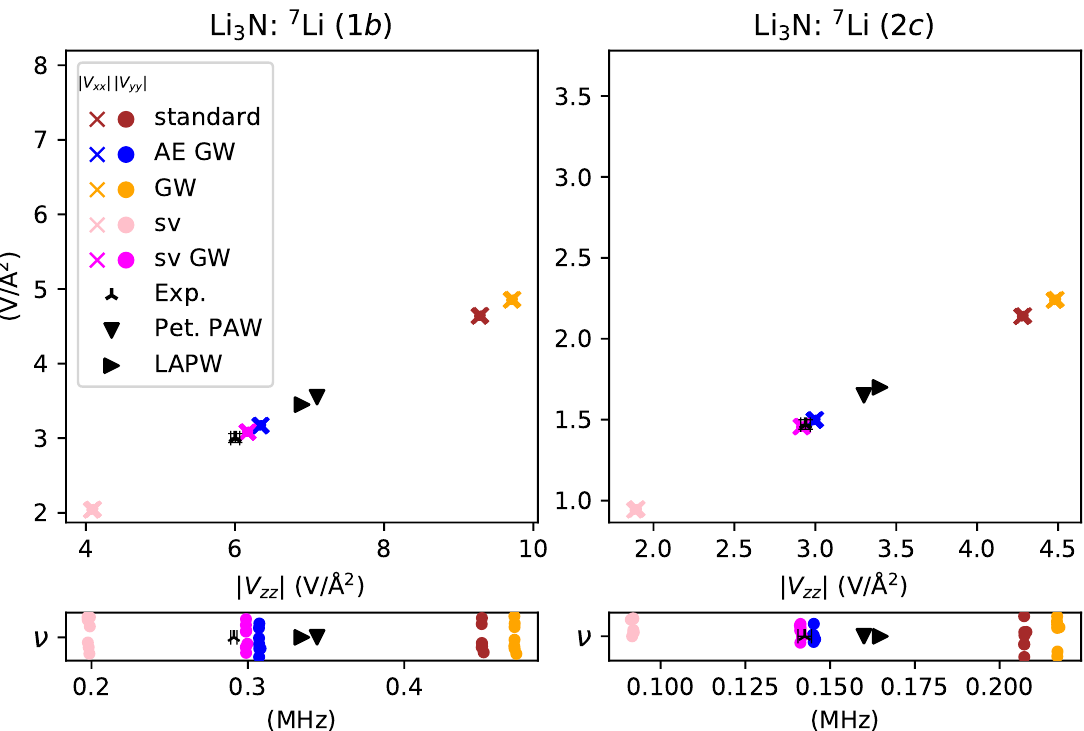
Figure 5. EFG plots for both 7 Li sites, denoted by their Wychoff positions, in Li 3 N are shown at the top; the corresponding NQR frequencies are shown underneath. Colored markers show a computed value for each PAW potential and experimental data [40] is shown as a three-pointed star. The potential with the best agreement to experiment is sv GW, with δ = 3%, and the worst being the GW potential with δ > 50%. Literature data [16], shown in black, were calculated using both a PAW and LAPW method. The V zz value is computed to be negative for the 1 b site and positive for the 2 c